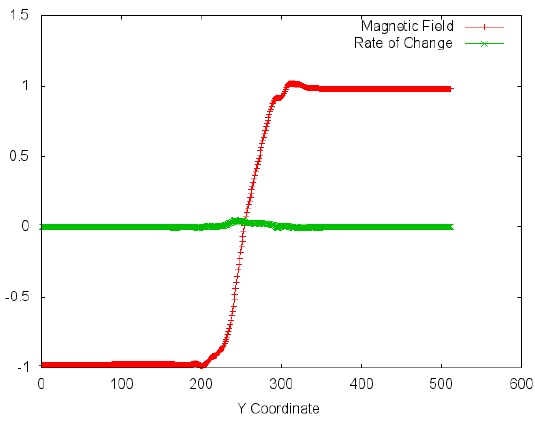
Fig. 3. The average magnetic field strength in the ˆ x (reversing) di- rection as a function of vertical distance in the computational box. The second line shows the field gradient.